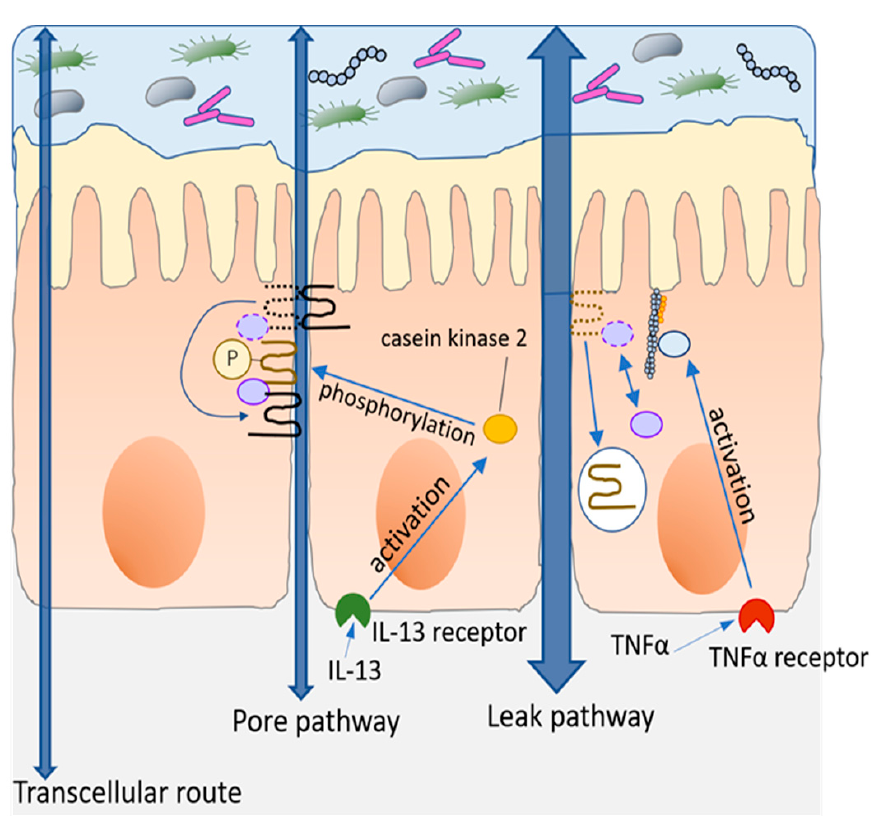
Figure 3. The mode of action for opening pore and leak pathways.